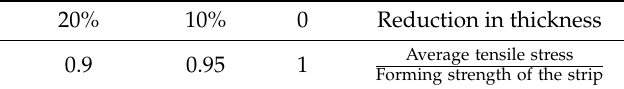
Table 2. Variations of the rolling force versus the average tensile stress.